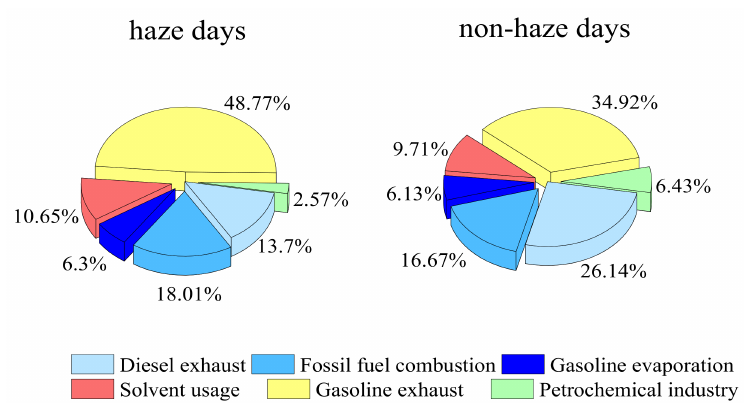
Figure 5. The proportion of each source during different pollution